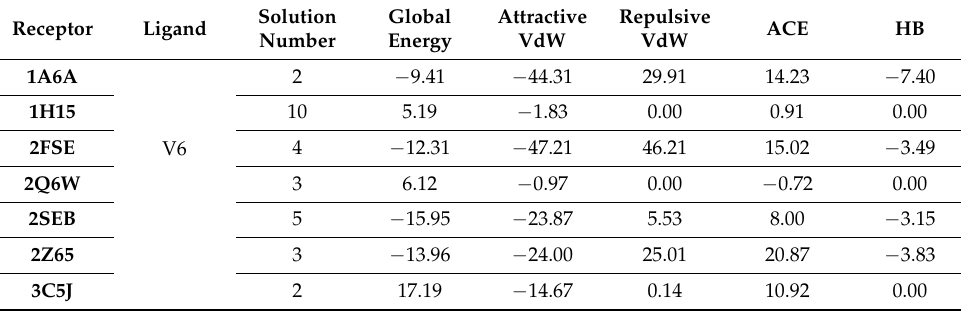
Table 4. Docking result of vaccine 6 construct and human leukocyte